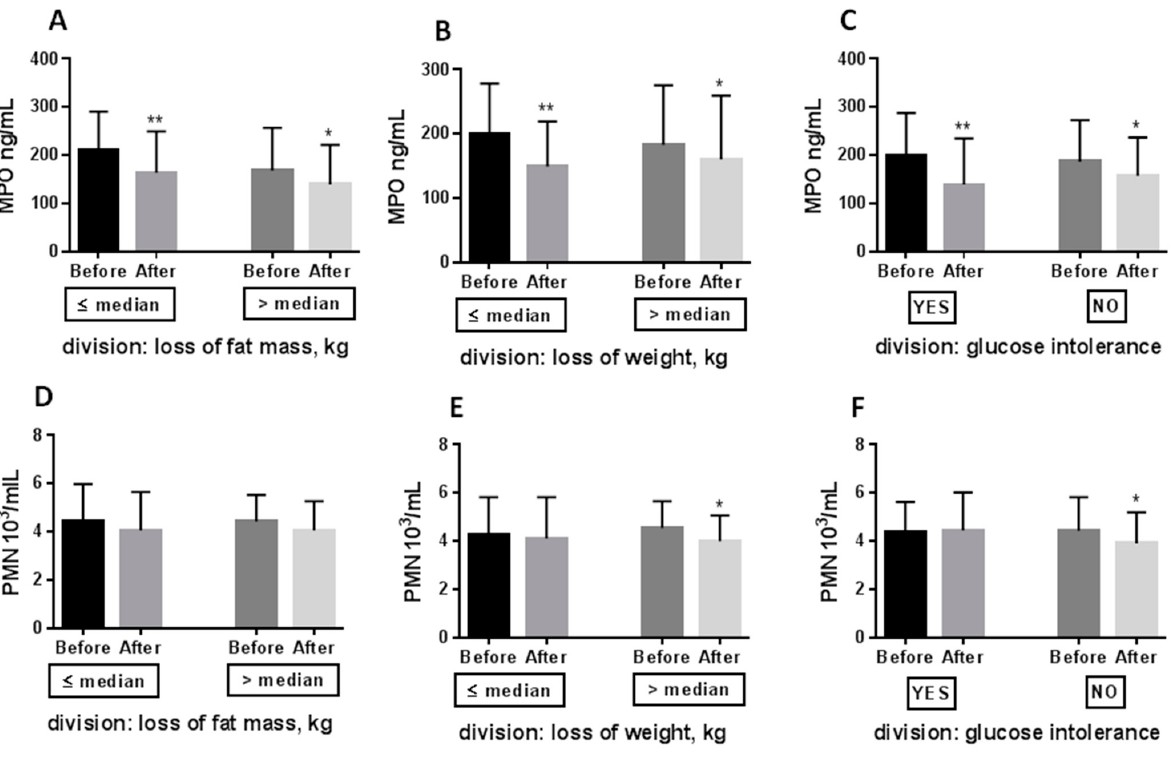
Figure 3. Effect of 8 weeks caloric restriction on serum myeloperoxidase activity ( A – C ) and neutrophile count ( D – F ). Patients after caloric restriction were divided according to the median value regarding the fat mass loss, the bodyweight loss, and the glucose concentration after 2 h of OGTT at baseline. The data were analyzed using the paired/unpaired t -tests depending on Gaussian/non-Gaussian distribution. Significance difference Before vs. After: * p < 0.05; ** p < 0.01. Abbreviation: MPO—myeloperoxidase, PMN—polymorphonuclear leukocytes.